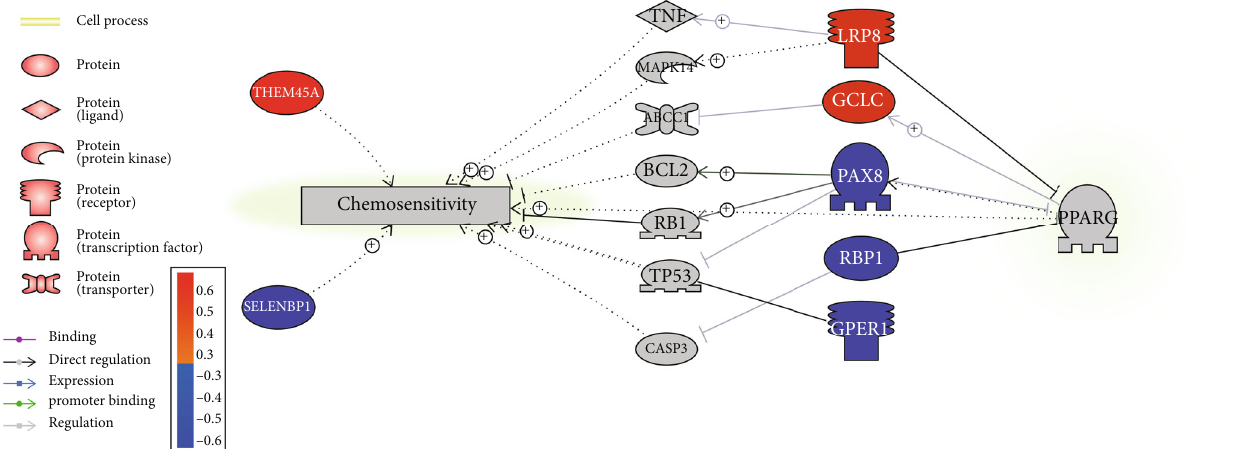
Figure 3: Cofunctional genes of PPARG to play roles in the chemosensitivity in HSCC patients. Nodes in red were positively correlated with PPARG in terms of expression; nodes in blue were negatively correlated with